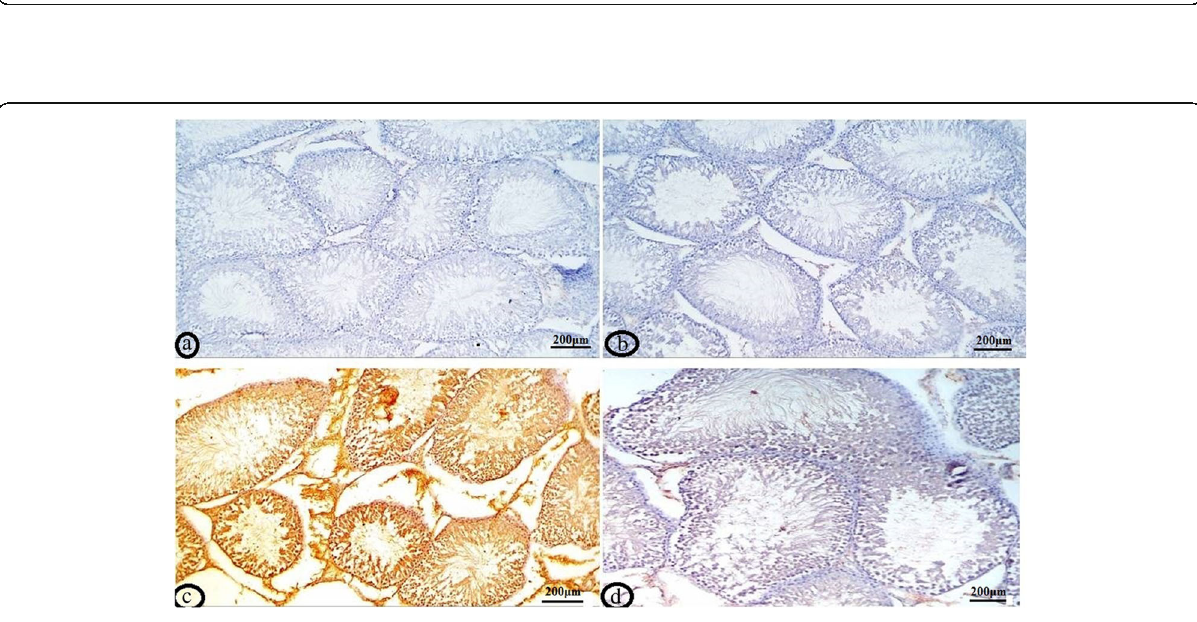
Fig. 7 Photomicrographs of testicular sections of different groups, hematoxylin, and eosin. a , b Testicular sections from control and PSO groups, respectively, showing normal histological features of seminiferous tubules. c Testicular section from Al 2 O 3 -administrated rat showing the degenerative, vacuolization, and necrotic changes specially in spermatogonial cell layer and in some areas of the germinal epithelium as well as interstitial edema and congestion of blood vessels (arrows), interstitial edema, (asterisk) d testicular section from the co-administrated group with PSO and Al